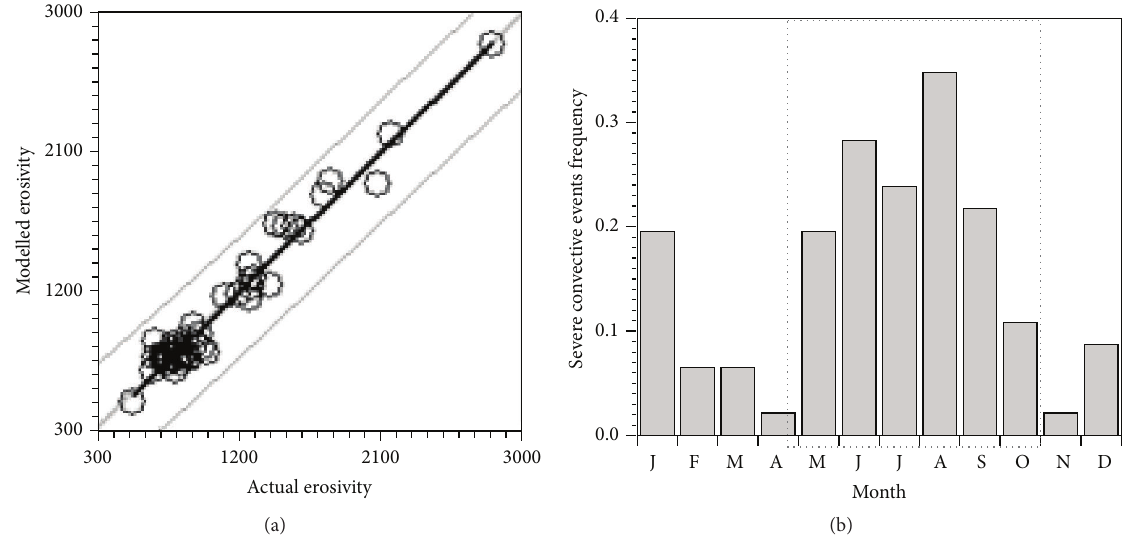
Figure 4: (a) Scatterplot between modelled (equation (1)) and actual (( R )USLE)-based rainfall erosivity. The black line is the interpolating line; the bold grey line denotes the 1: 1 line; grey curves are 0.99 confidence limits of the interpolating line. (b) Monthly regime of severe convective events frequency estimated over 1957–2002 in Europe